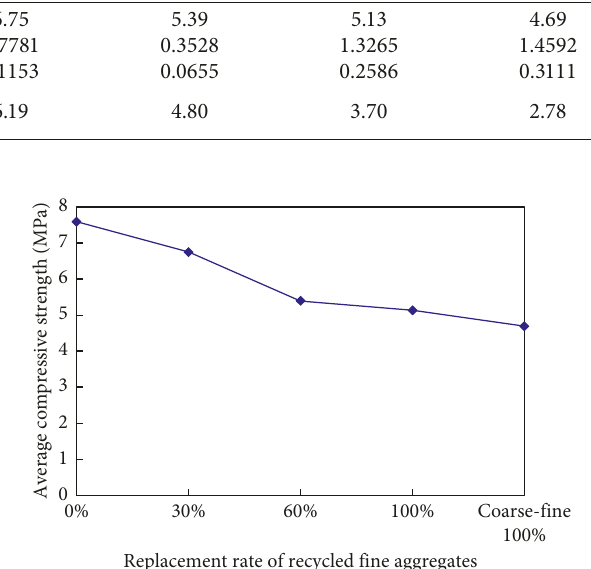
Figure 8: Compressive strength curve of recycled fine aggregates with different substitution ratios. Table 8: Summary of the test results of compressive strength of recycled blocks with different substitution rates of MU7.5. Block